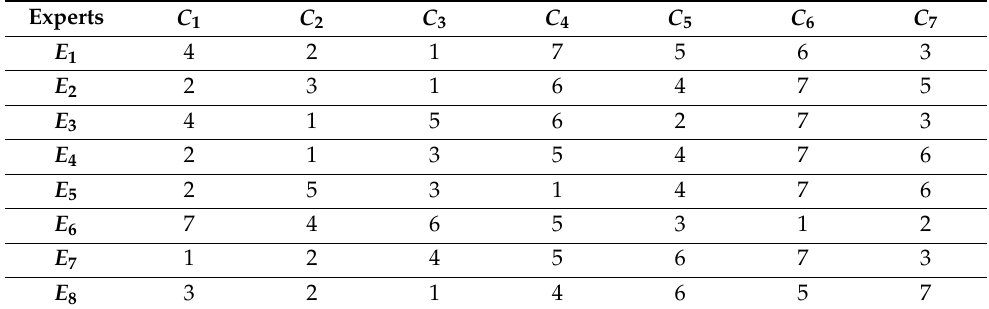
Table 6. Criteria order based on each expert